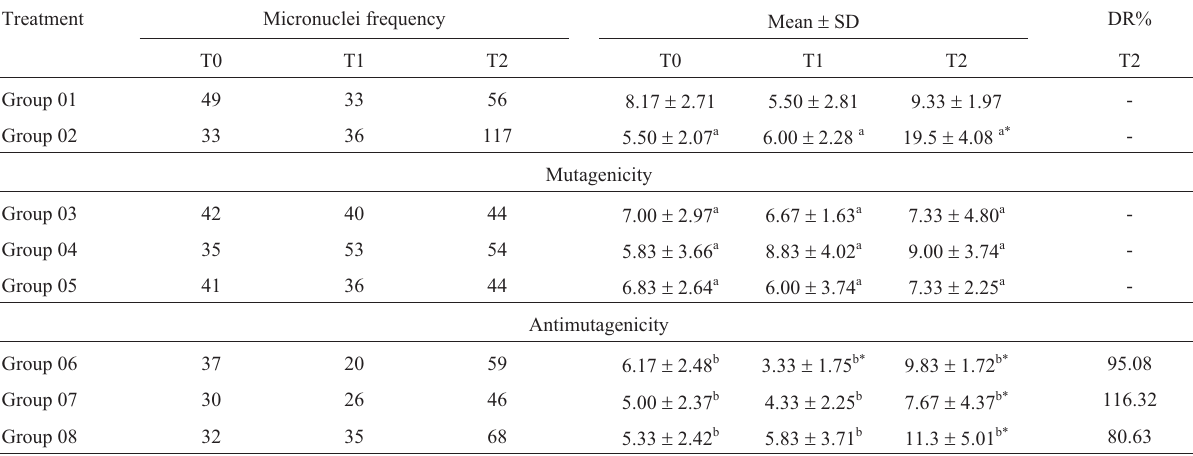
SD: Standard deviation; DR%: Damage reduction percentage. a Statistically compared to the control (Group 01). b Statistically compared to the dam- age-inducing agent (Group 02). *statistically significant difference (unpaired Student’s t-test, p < 0.05). Time points T0, T1 and T2: samples of blood taken within interval of 24 hours.